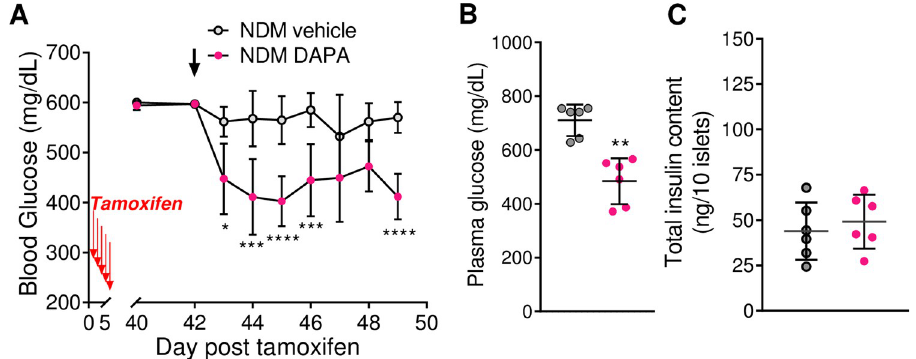
Fig 5. Dapagliflozin therapy does not improve insulin content in long-standing NDM NDM mice treated with vehicle or DAPA, starting on day 42 post-tamoxifen (A) Blood glucose over time and (B) plasma glucose 10 days after treatment (n = 6 mice/group). (C) Total islet insulin content 10 days after treatment with vehicle or DAPA (n = 6 mice/group). Grey = vehicle-treated NDM and pink = DAPA-treated NDM mice. Arrow indicates initiation of DAPA therapy. Data are expressed as mean ± SD � P < 0.05, �� P < 0.01, ��� P < 0.001, ���� P <